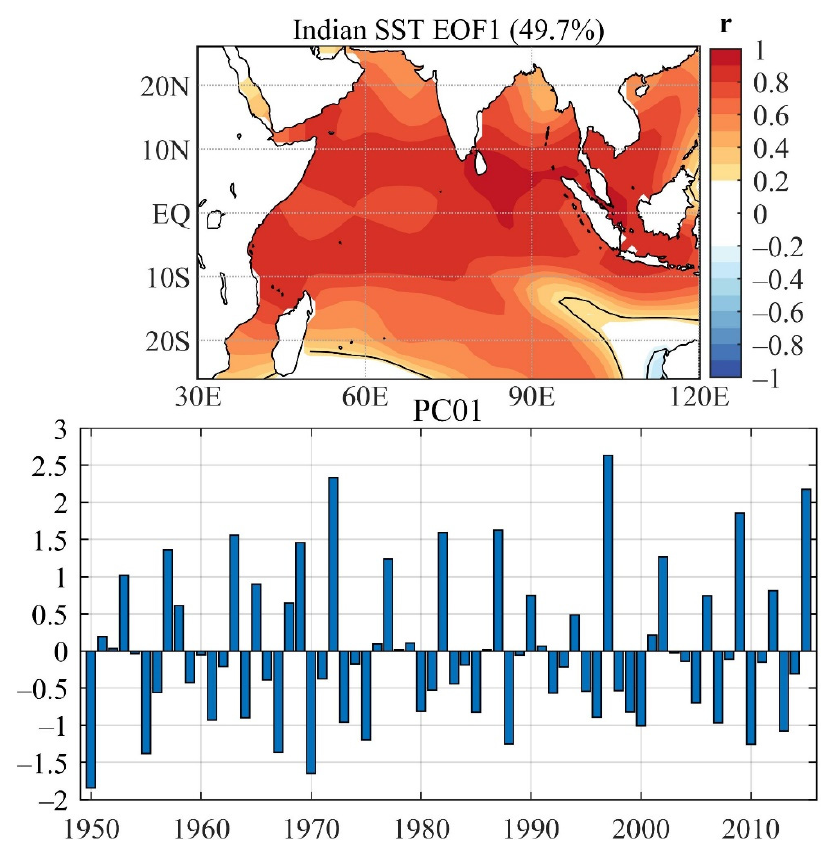
Figure 2. First EOF mode of the interannual SST anomalies in the tropical Indian Ocean computed for the southern summers of the 1951–2016 period: spatial loading pattern and principal component (PC) time series. Graphical display is the same as that in Figure 1.